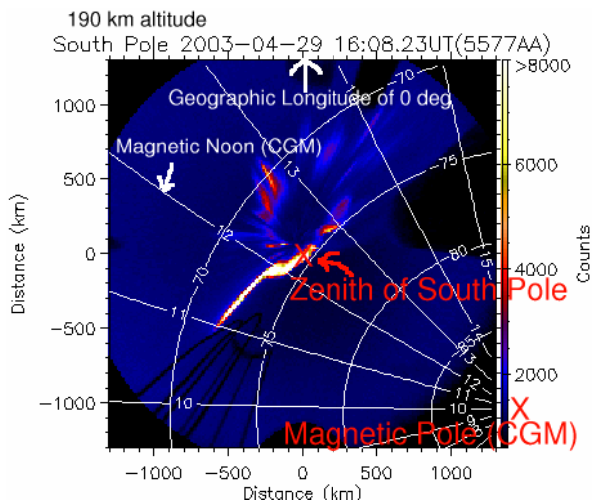
Fig. 1. Sample 557.7nm all-sky image mapped onto a spherical shell at 190km altitude above the South Pole. The perspective is that of an observer looking down from above. The red Xs at the cen- ter of the image and to its right mark the locations geographic zenith and the magnetic pole, respectively. The direction of the Greenwich prime meridian (0 ◦ geographic longitude) is indicated at the top of the image. “Distance” labels along the ordinate and abscissa signify arc lengths from the point that intersects South Pole Stations zenith at 190km altitude. White lines indicate magnetic latitude and MLT in the CGM coordinates. In-figure labels “ − 70” and “12” reference CGM latitude –70 ◦ , and MLT noon. Because emissions at partic- ular locations on the sphere have vertical extents, they may appear as rays that point toward magnetic zenith. The black structure in the lower left and the occlusions in the upper right detail regions of interference in the all-sky field of view. The background appears relatively bright compared with most other presented images. This is an instrumental effect due the very strong central